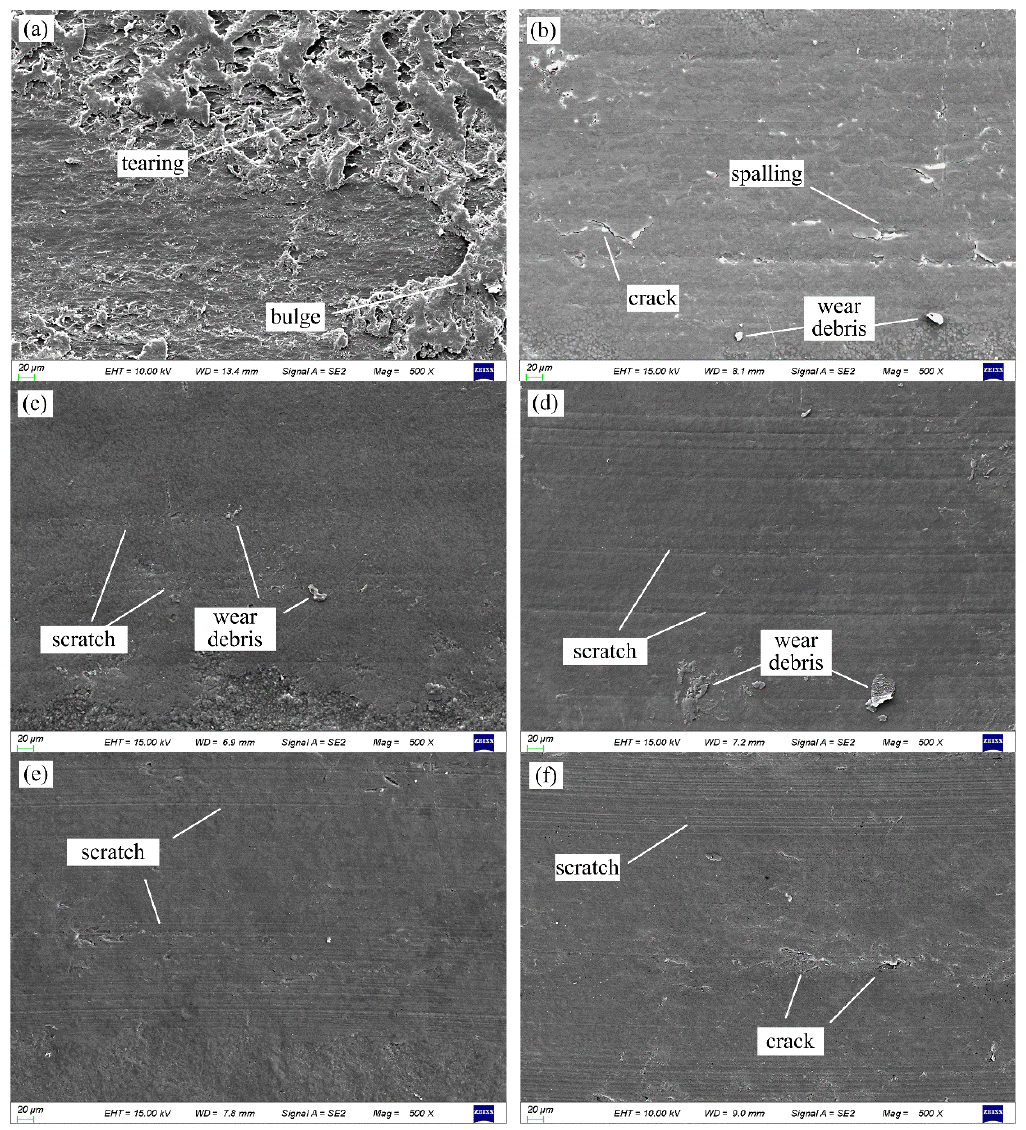
Figure 9. SEM photos of the representative worn surface morphology. ( a ) PMMA, P/L = 1.5, ( b ) 15 wt % PTFE filled PMMA, P/L = 1.5, ( c ) 25 wt % PTFE filled PMMA, P/L = 1.0, ( d ) 15 wt % PTFE filled PMMA, P/L = 1.0, ( e ) 20 wt % PTFE filled PMMA, P/L = 1.22, ( f ) 25 wt % PTFE filled PMMA, P/L =